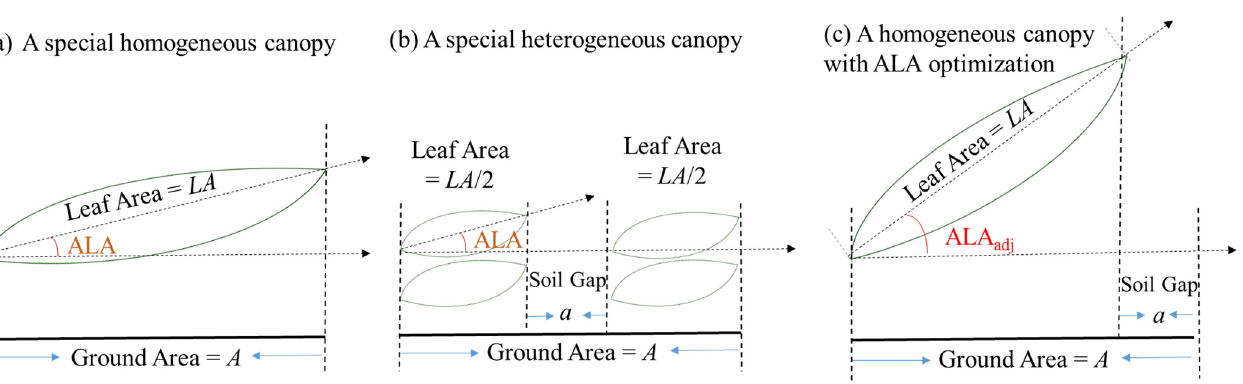
Figure 2. Conceptual effect of ALA adj in ( c ) on bridging the difference in soil gap fraction cover between ( a ) a homogeneous canopy case and ( b ) a heterogeneous canopy case with the same leaf area index (LAI). LAI = LA/A.